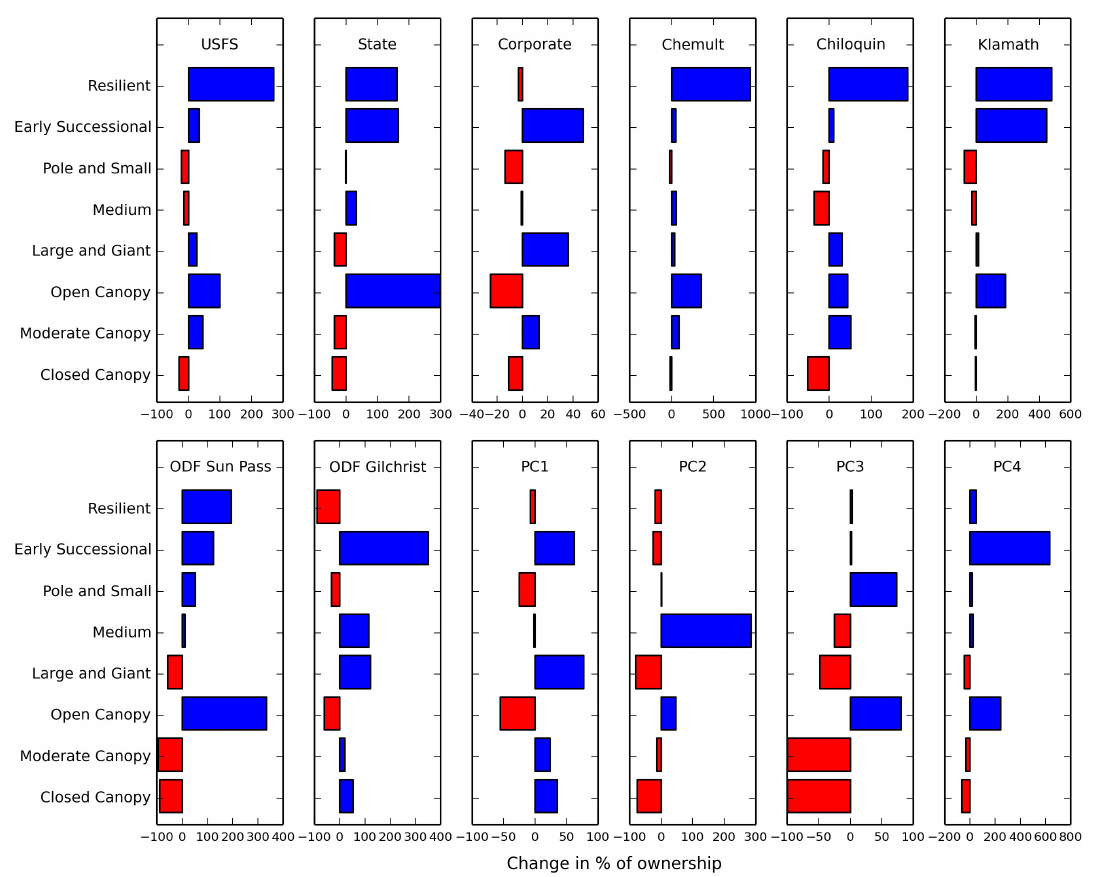
Fig. 5. Change in forest structure characteristics between model simulation years 1 and 50, between and within forest ownership categories.